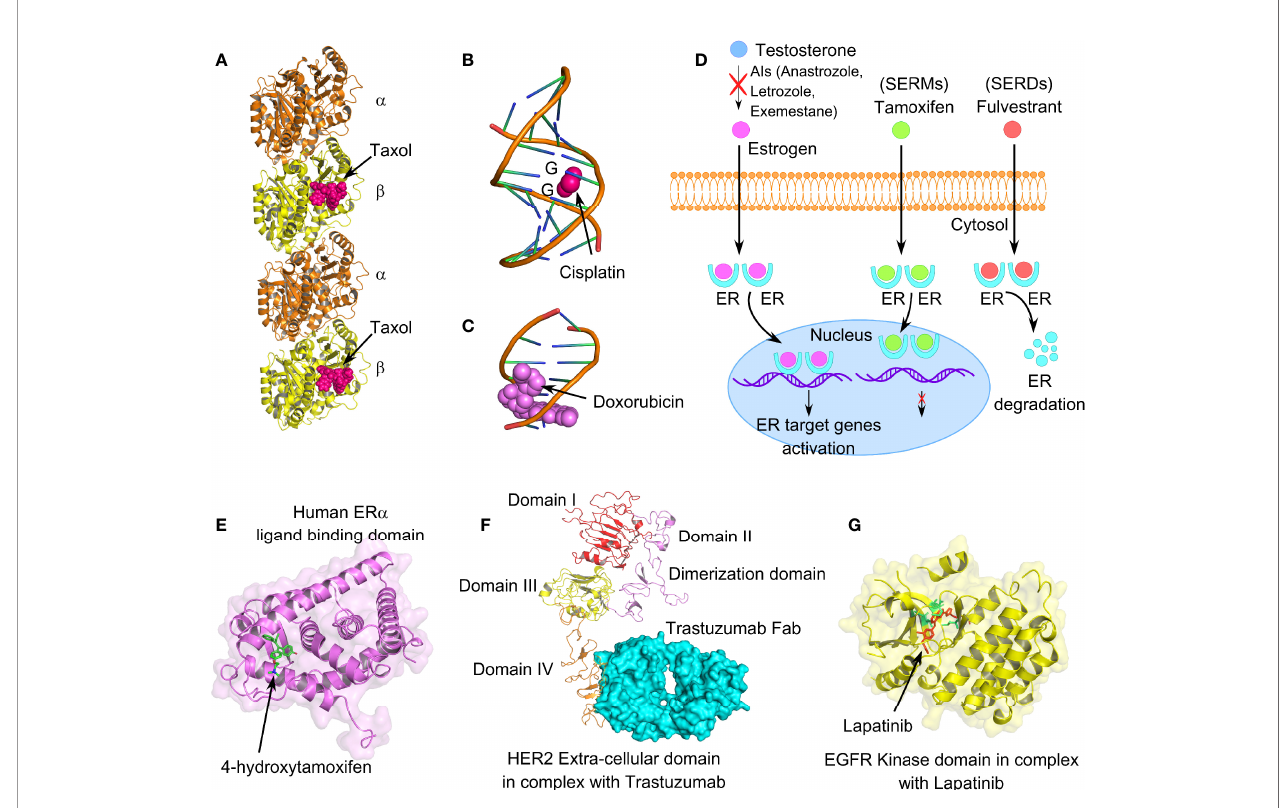
FIGURE 4 | Mechanism of action of different anticancer drugs for the treatment of breast cancer. (A) Tubulin dimers stabilized with microtubule-stabilizing drug paclitaxel (PDB code: 6WVR). (B) Interaction of chemo drug cisplatin with double-stranded DNA (PDB code: 1AIO), forming major adducts of cisplatin with guanine nucleotides. (C) Doxorubicin intercalation with DNA base pairs (PDB code: 2DES). (D) Cartoon representation of mechanism of action of endocrine therapeutic drugs, such as selective estrogen receptor modulators (SERMs), selective estrogen receptor degrader (SERDs), and aromatase inhibitors (AIs). (E) Human ER- a - ligand-binding domain in complex with tamoxifen (PDB code: 3ERT). (F) Extracellular domain IV of HER2 in association with recombinant humanized IgG1 monoclonal antibody, trastuzumab (PDB code: 6OGE). (G) EGFR kinase domain in complex with lapatinib, a selective receptor tyrosine kinase inhibitor, targeting both EGFR and HER2 (PDB code: 1XKK). Lapatinib interacts in the ATP-binding pocket of EGFR (L718, V726, A743, M793, and L844); highlighted in lemon